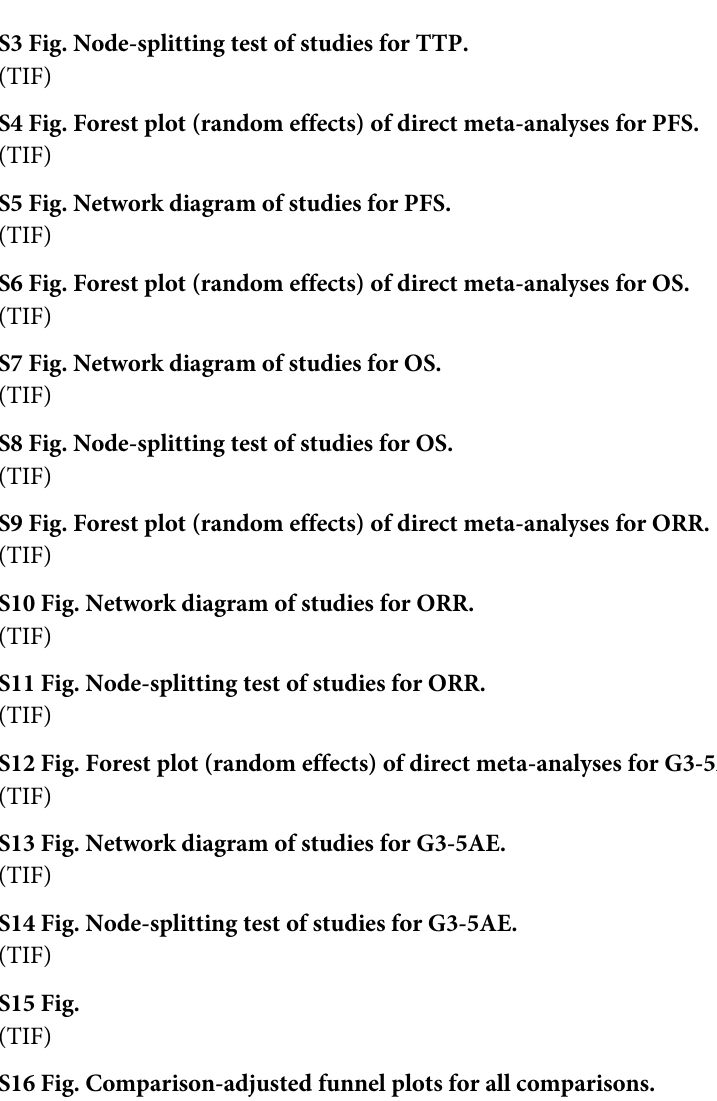
S3 Fig. Node-splitting test of studies for TTP. (TIF) S4 Fig. Forest plot (random effects) of direct meta-analyses for PFS. (TIF) S5 Fig. Network diagram of studies for PFS. (TIF) S6 Fig. Forest plot (random effects) of direct meta-analyses for OS. (TIF) S7 Fig. Network diagram of studies for OS. (TIF) S8 Fig. Node-splitting test of studies for OS. (TIF) S9 Fig. Forest plot (random effects) of direct meta-analyses for ORR. (TIF) S10 Fig. Network diagram of studies for ORR. (TIF) S11 Fig. Node-splitting test of studies for ORR. (TIF) S12 Fig. Forest plot (random effects) of direct meta-analyses for G3-5AE. (TIF) S13 Fig. Network diagram of studies for G3-5AE. (TIF) S14 Fig. Node-splitting test of studies for G3-5AE. S15 Fig. S16 Fig. Comparison-adjusted funnel plots for all comparisons.